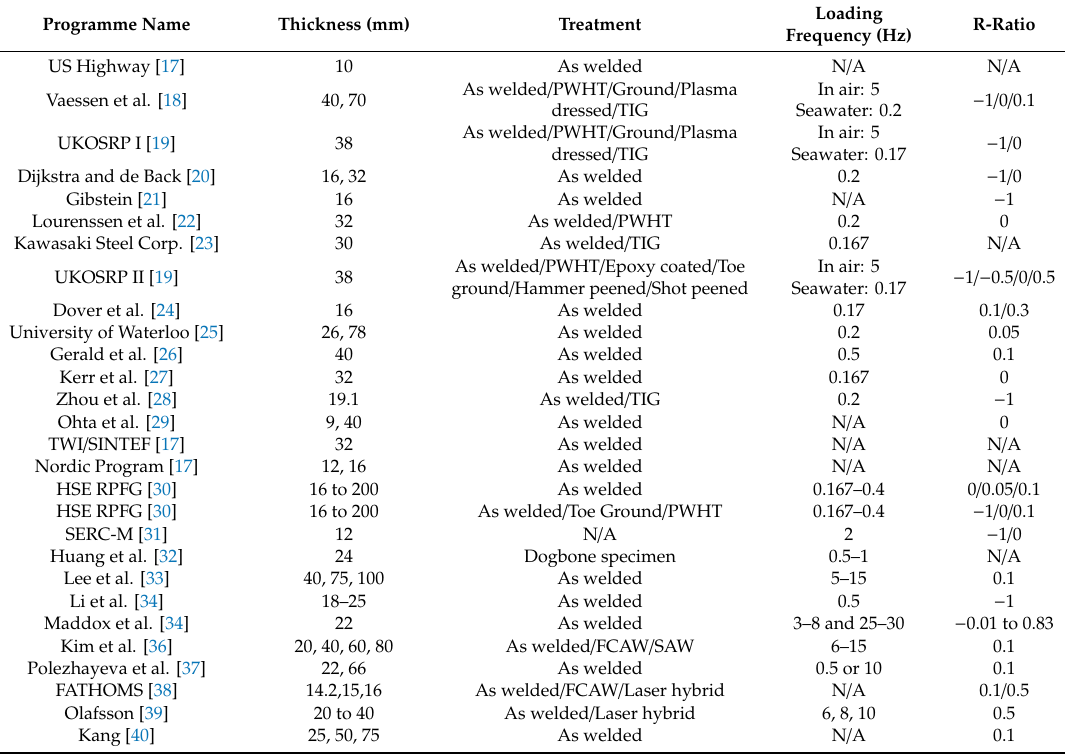
Table 3. Testing characteristics of the fatigue